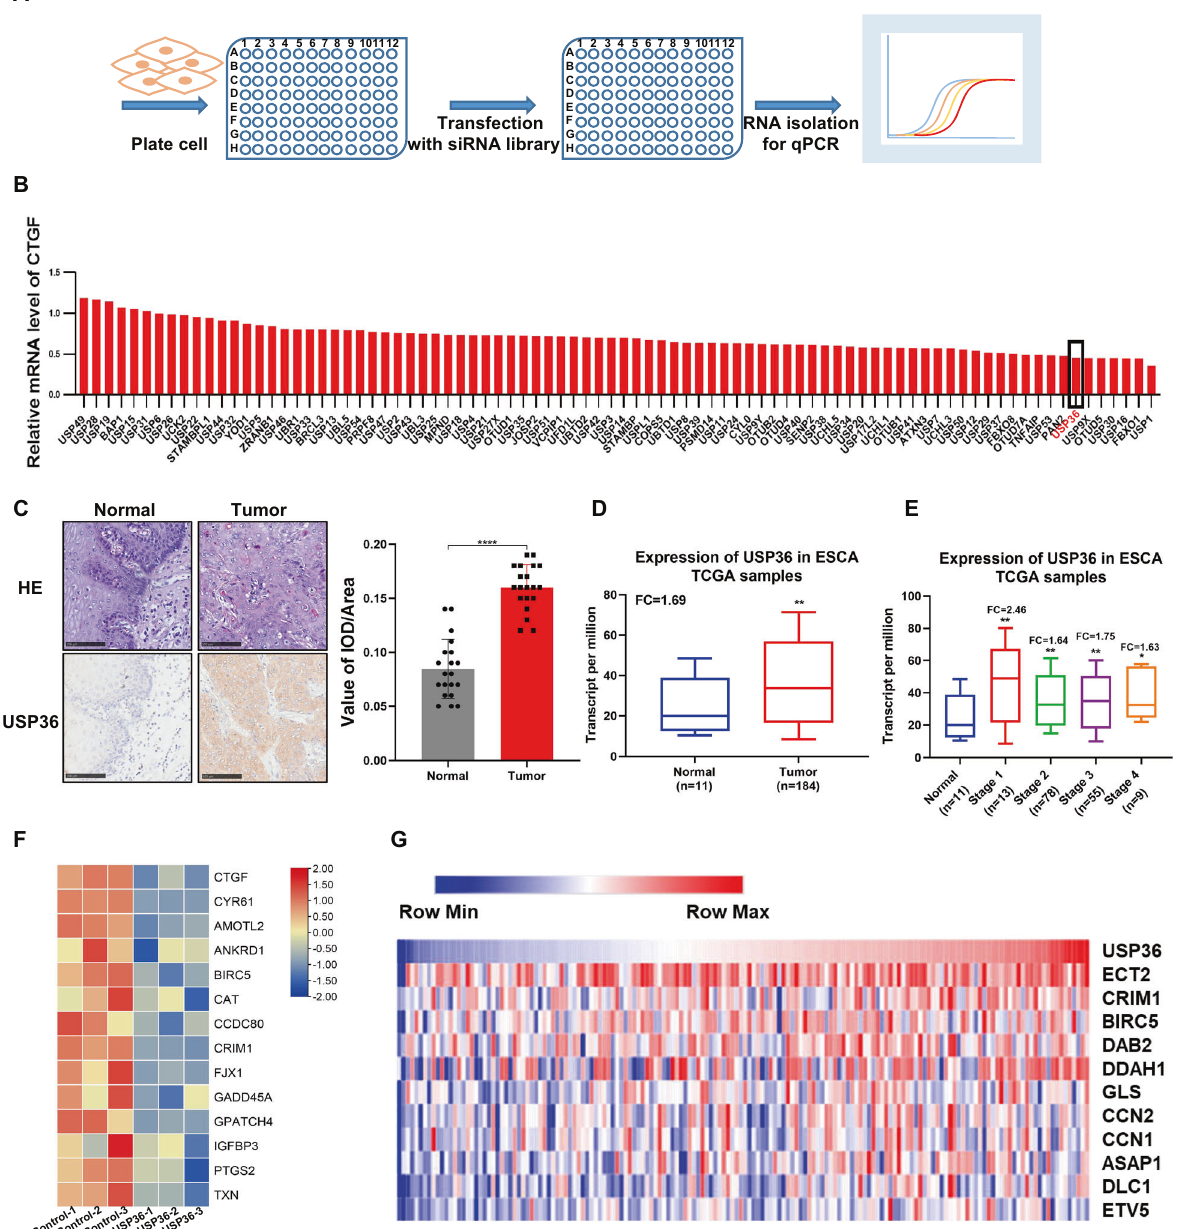
Fig. 1 The possible regulation between USP36 and Hippo pathway in ESCC. A Diagram of the screening procedure used to identify deubiquitinases that modulate Hippo signaling in HEK293 cells. B The relative expression level of CTGF(NM_001901.4) in HEK293 cells transfected with deubiquitinases in the screening library. The RT-qPCR results were normalized to 1. USP36 is marked in red. C USP36 expression was markedly increased in 20 ESCC tissues compared with adjacent nontumor tissues as analyzed by IHC. Scale bar, 100 µm. Integrated optical density (IOD) values for IHC staining between normal and tumor tissues are presented in the histogram. USP36 antibody was veri fi ed for IHC by immuno fl uorescence in Supplementary Fig. 1A. D The expression level of USP36 in ESCC tumor samples versus normal samples in TCGA was shown in the histogram. E Expression of USP36 in ESCC between normal tissues and tumors tissues of different stages is presented in the histogram. F The heatmap showed differentially expressed Hippo pathway-related genes whose expression was seriously decreased by siUSP36 in ECA109 cells. G Heatmap for USP36 and Hippo signaling pathway target gene expression in TCGA ESCC datasets (in the diagram, red denotes high gene expression levels, blue denotes low gene expression levels). The quanti fi cation of the positive correlation between USP36 and the YAP and TAZ target genes is shown in Supplementary Fig. 1D. **** P <